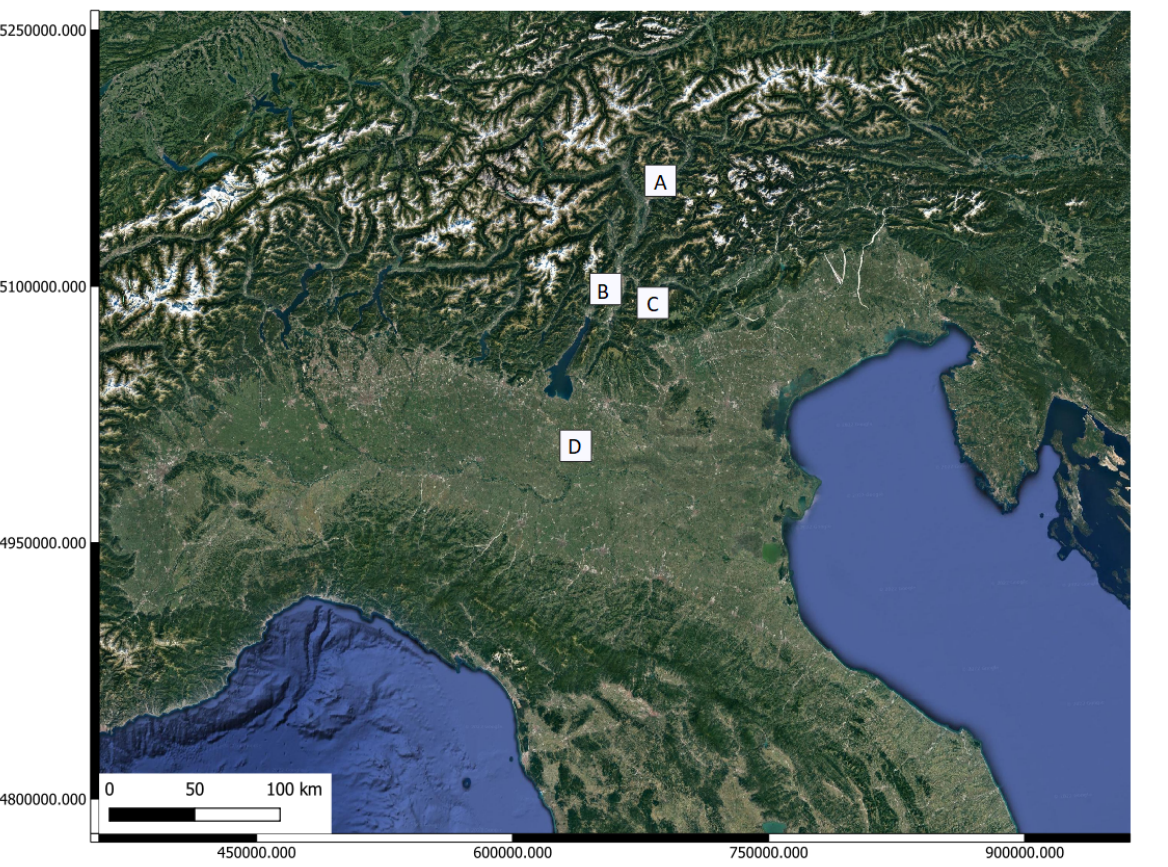
Figure 1. Google Earth image with the location of the four study sites in Italy. (A) Renon (Fluxnet code: IT-Ren); (B) Monte Bondone (Fluxnet code: IT-MBo); (C) Lavarone (Fluxnet code: IT-La2); (D) Bosco della Fontana (ICOS code: IT-BFt). CRS map: WGS84 /UTM zone